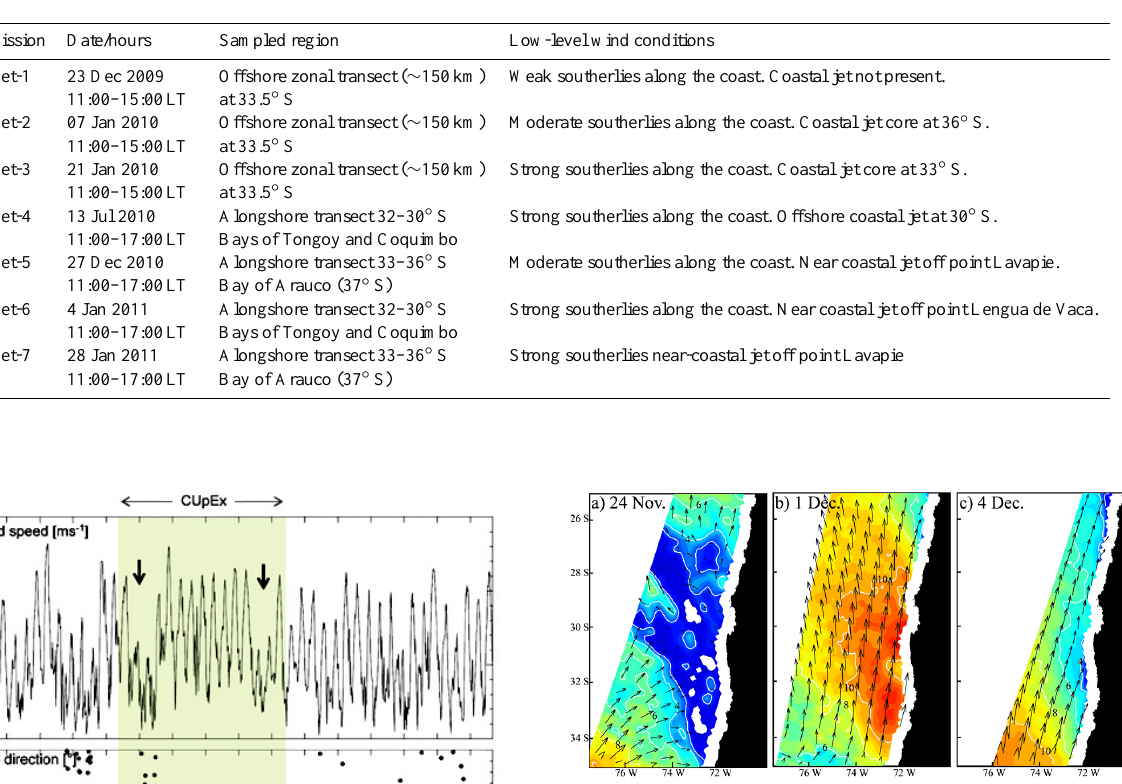
Table 4. Summary of research flights using the AIMMS-20 mounted in the DGAC Beechcraft King Air BE90. Further details provided online at http://dgf.uchile.cl/rene/AIMMS20/